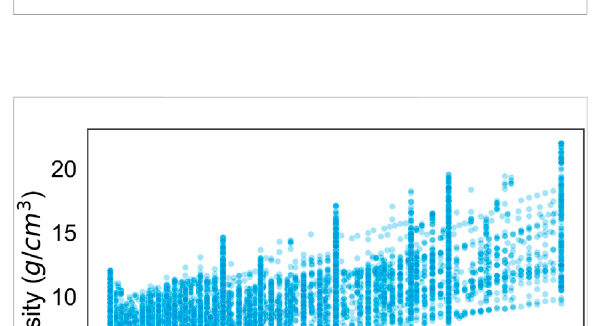
FIGURE 1 Results of regression model predicting density (g/cm 3 ). The prediction accuracy ( R 2 ) is approximately 0.99.